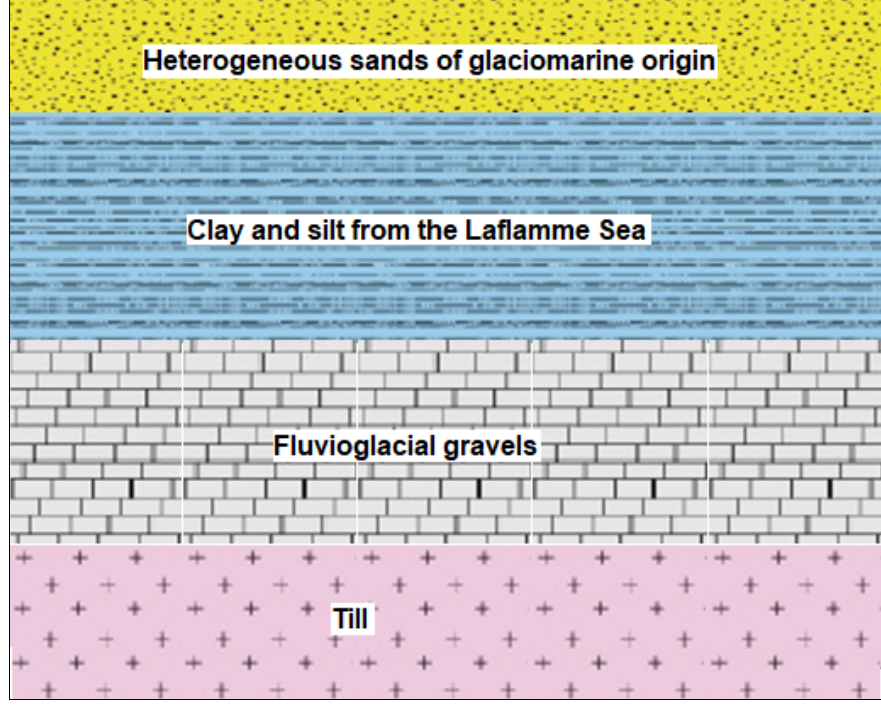
Figure 4. Generalized stratigraphy for the Saguenay-Lac-Saint-Jean region (modified from